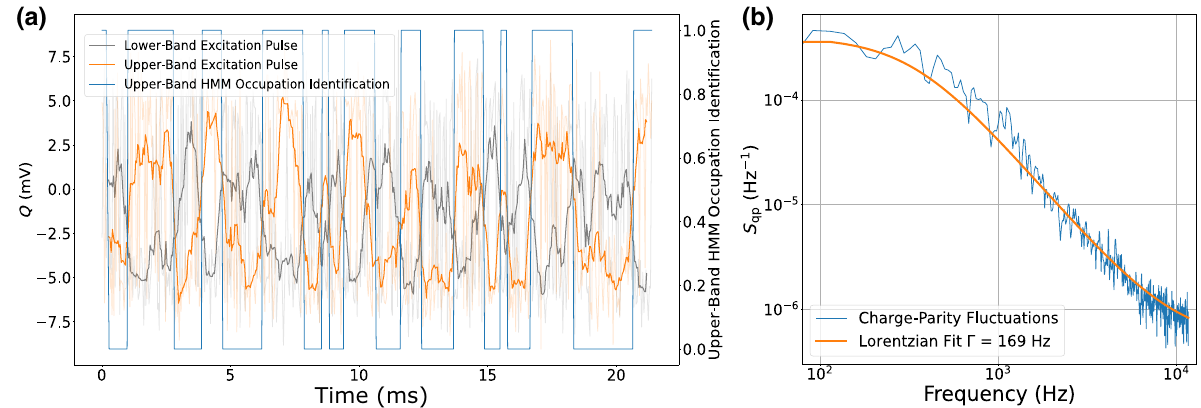
FIG. 3. Charge-parity fluctuations measured in the 1-2 transition. (a). A midband qubit excitation pulse of 10 μ s is applied to one charge-parity qubit state frequency followed by the opposite charge-parity qubit state frequency. These measurements followed one another with a total duty cycle of approximately 50 μ s. The left vertical side of (a) indicates the quadrature channel demodulated voltages in faded color, phase tuned for high resolution between the ground and excited states, of the single-shot data points. As a guide for the eye, the 10-point running average of the output voltages are shown in bold. The hidden Markov model results, applied to the single-shot data, are displayed on the right vertical axis. (b). The quasiparticle dynamics, fit to a Lorentzian distribution on a white-noise background, reveal a typical dwell time of 1 /(cid:6) = 5.9